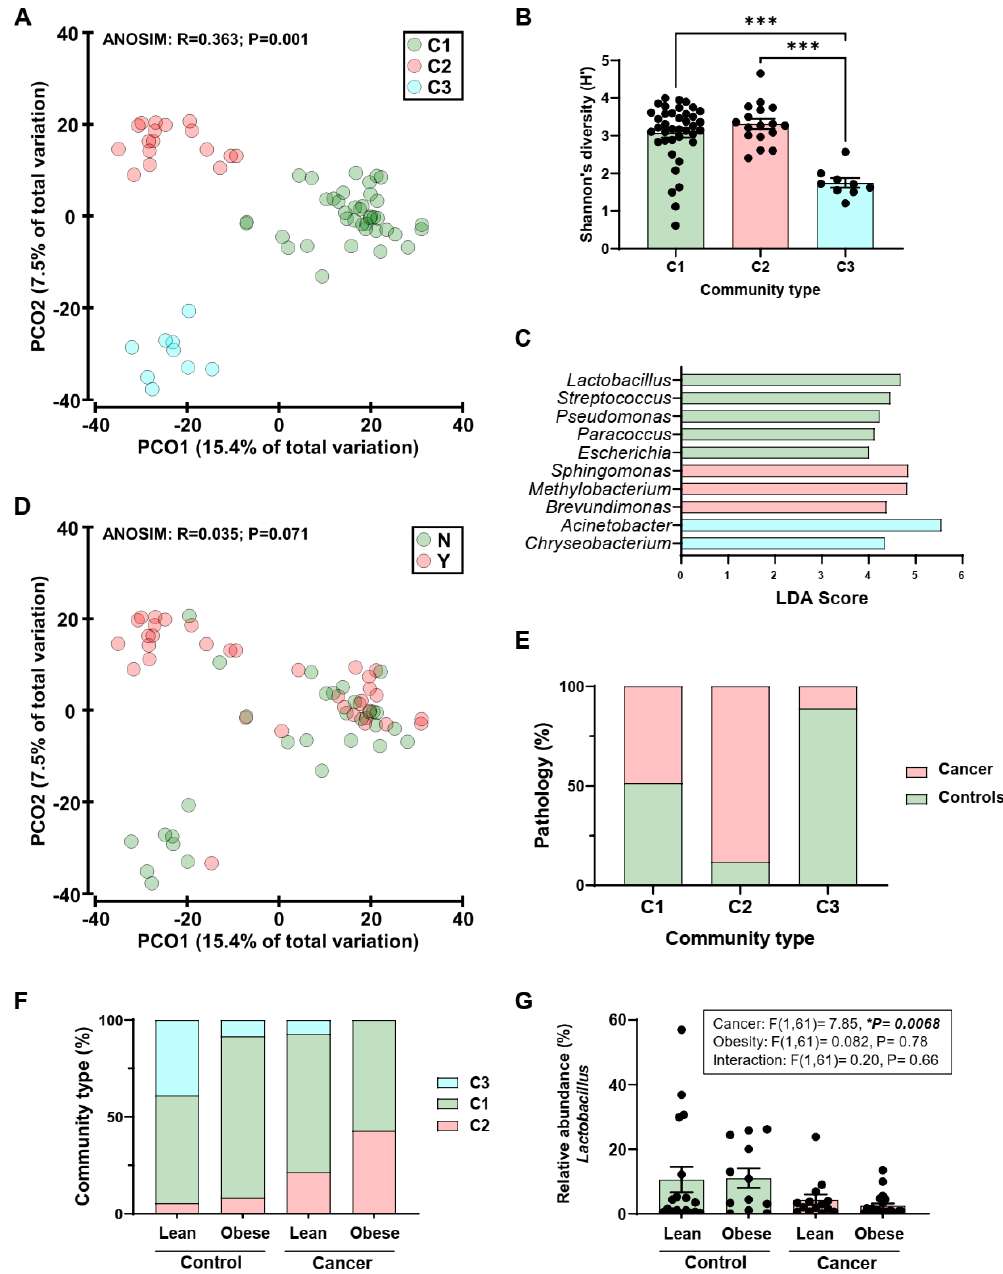
Figure 1. Endometrial microbiota of patients with endometrial cancer and controls. ( A ): Principal coordinate (PCO) analysis of bacterial beta diversity across community types (C1–C3). The ordina- tions were generated from Bray-Curtis resemblance matrices on square-root transformed bacterial relative abundances. Analysis of similarities (ANOSIM) was employed to test for significant differ- ences in beta diversity. ( B ): Shannon’s diversity across community types. Significance was analyzed by Kruskal-Wallis with Dunn’s multiple comparisons test. *** p < 0.001. ( C ): Genera found to be significantly differentially abundant across community types. Taxa were identified using Linear discriminant analysis Effect Size (LEfSe). Genera with a Linear discriminant analysis (LDA) score > 4 are displayed. ( D ): Principal coordinate analysis of bacterial beta diversity between patients (Y, tumor sample) and controls (N). ( E ): Prevalence (%) of patients with endometrial cancer across community types. ( F ): Prevalence (%) of community types in patients and controls stratified according to body mass index (BMI). ( G ): Relative abundance (%) of Lactobacillus in patients and controls stratified according to BMI. Significance was tested using two-way ANOVA, * p <